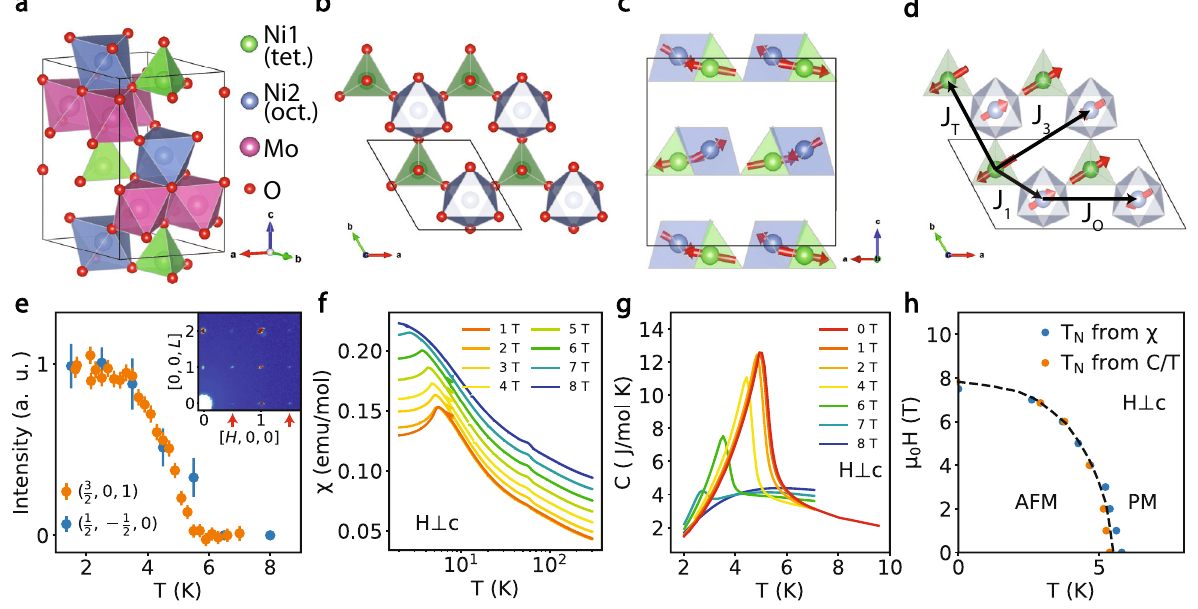
Fig. 1 | Structure, Brillouin zone, magnetic Bragg peak, d.c. susceptibility and magnetic Bragg peaks are indicated by red arrows. The vertical error bars are speci fi c heat of Ni 2 Mo 3 O 8 . a A schematic of the structure of Ni 2 Mo 3 O 8 with a -, b -, statistical errors of 1 standard deviation. f The d.c. susceptibility with 1 – 8T mag- c -axis labeled. b The octahedral coordinated Ni ions (blue) and the tetrahedral netic fi elds perpendicular to the c -axis. Data are shifted by magnetic fi eld × 0.01emu/molTforclarity.Magnetictransitionissuppressedinthe8T fi eld. g The coordinatedNiions(green)formaquasi-2Dhoneycomblattice. c , d Side(alongthe b -axis) and top (along the c -axis) view of the magnetic structure of Ni magnetic contribution to the speci fi c heat C mag with 0-8T magnetic fi elds per- 2 Mo 3 O 8 . The black frames indicate the size of magnetic unit cell and black arrows denote pendicular to the c -axis. Magnetic transition is suppressed in the 8T fi eld. h Temperature versus magnetic fi eld phase diagram from d.c. susceptibility and magnetic exchange couplings along different directions. e Temperature depen- dence of the intensities in arbitrary units (a. u.) of two magnetic Bragg peaks at speci fi c (3/2,0,1) and (1/2, − 1/2,0).Insetshows a 2Dcolor plot inthe [ H , 0, L ] plane,in which